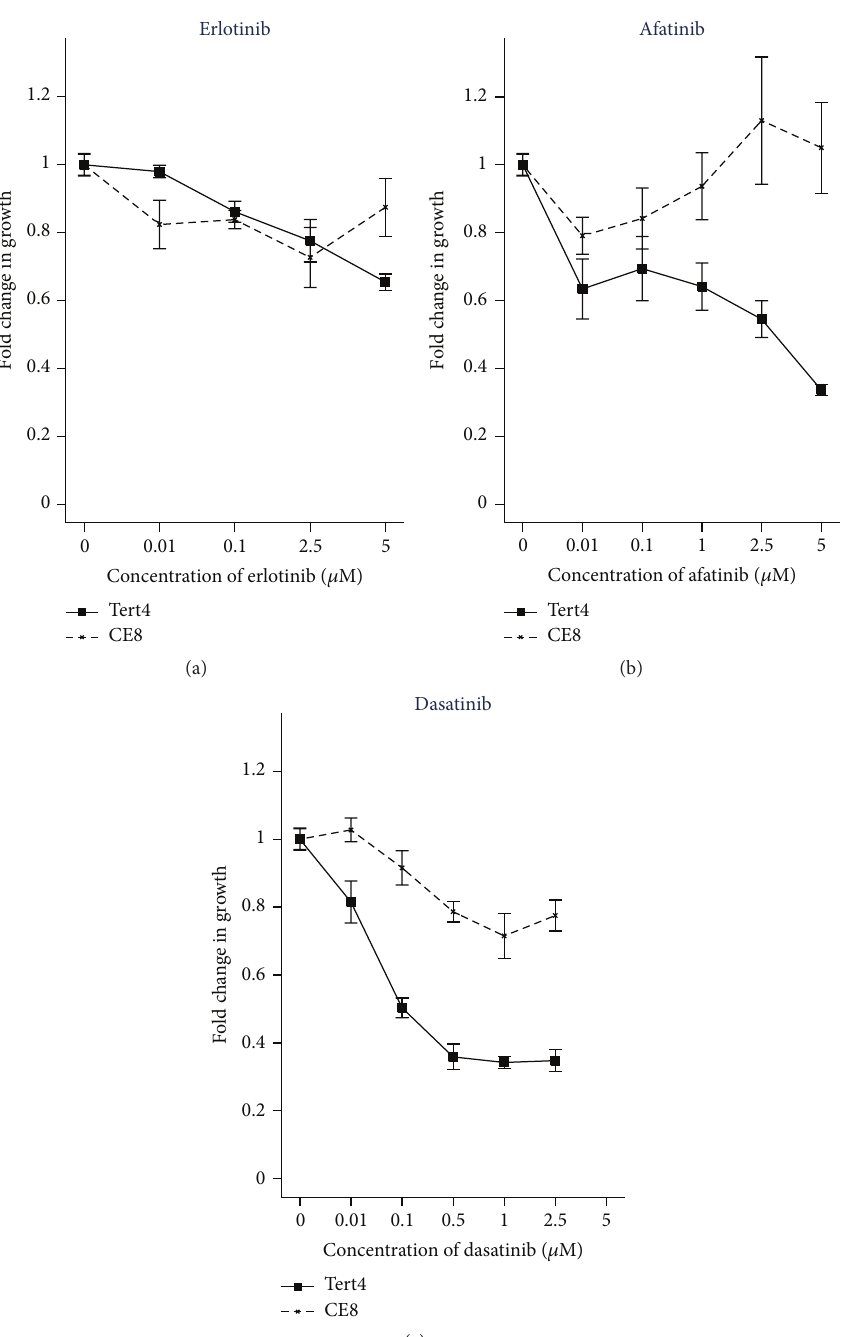
Figure 3: Cell viability was determined by non-Radioactive Cell Proliferation Assay (MTS) for erlotinib (concentrations: 0.01–5 𝜇 M), afatinib (concentrations: 0.01–5 𝜇 M), and dasatinib (concentrations: 0.01–5 𝜇 M) in hMSC-TERT4 (solid line) and hMSC-TERT20-CE8 (dashed lines). The results are presented as fold changes compared to the nontreated cells. The MTS assays were performed twice with total of 9 replicates for the erlotinib treated cells. The MTS assay was performed once with 6 replicates for the afatinib treated cells. The MTS assays were performed two or three times with at least a total of 12 replicates for the dasatinib treated cells. The cell viability is presented as mean value with 95% confidence interval for direct comparison. The cells were treated for 72